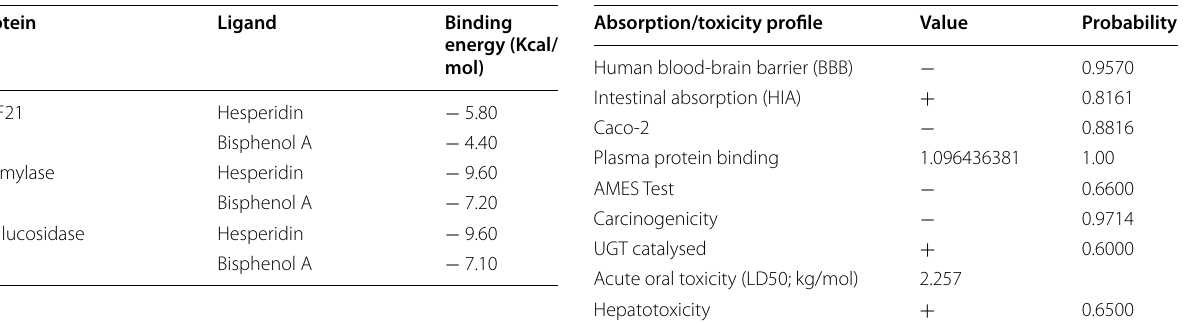
Table 3 In silico absorption and toxicity profile of the compounds as obtained from the AdmetSar server.